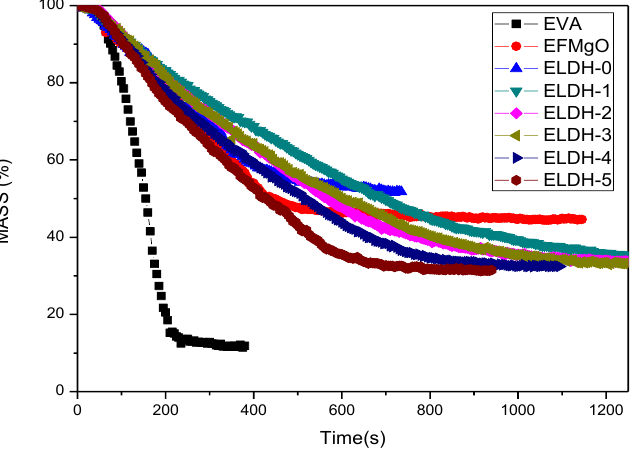
Figure 4. Mass of the EVA/LDHs composites. Digital photos of char residue. Figure 5 presents digital photos of char residue of EVA/LDHs composites. It can be seen that there is no visible char residua the pure EVA sample while charred residues left in the ELDH-0~ELDH-5 samples are significantly inte- grated as well as compact. Such a result is in line with data shown in Figure 4. LDHs, a material featuring its pore structure, is provided with excellent adsorption as well as flame retardation capacity, which increase the efficiency of flame retarding, and control the smoke generation. Furthermore, LDHs lead to the formation of a compact layer on the sample surface, which means that LDHs improve the structure of the charred layers and strengthen their thermal stability, guaranteeing better flame retardation and smoke sup- pression of flame retardant. The photographs after cone calorimeter test are well agreed with data shown in Figures 3 and 4. The char structure helps introduce the combustion of the flame retarding EVA composites. The formation of efficient ceramic materials prevents the transfer of heat mass between the flame zone as well as the burning substrate, protect the potential materials from continuously burning and retard the polymer cracking.